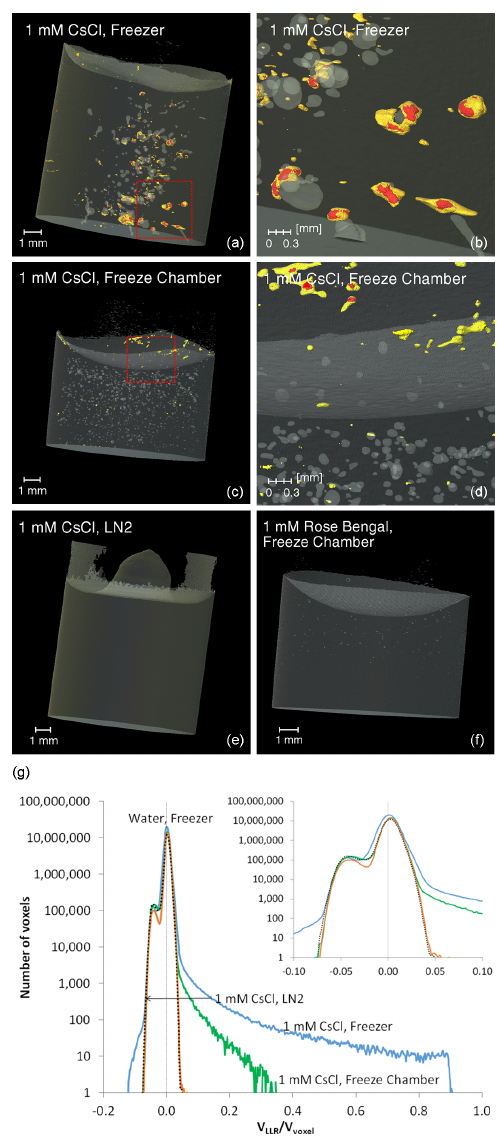
Figure 3. Reconstructed images and histograms of ice samples frozen using three freezing methods and with two different solutes. Samples were imaged using a ∼ 16µm voxel size and segmented to show air bubbles (light gray), the bulk ice matrix (darker gray), voxels where V LLR /V VOXEL is between 2 and 10% (orange), and voxels where V LLR /V VOXEL >10% (red). The sample vial is not shown. (a) 1.0mM CsCl solution frozen in freezer. (b) Magnifica- tion of the area in panel (a) identified by the dashed red square. (c) 1.0mM CsCl solution frozen in freeze chamber (without metal plates). (d) Magnification of the dashed-line area of panel (c) . (e) 1.0mM CsCl solution frozen in liquid nitrogen. No air bubbles or inclusions are visible at this scale. (f) 1.0mM rose bengal solu- tion frozen in freeze chamber. (g) Histogram showing distribution of voxel counts for the CsCl and Milli-Q water ice samples shown above: water ice frozen in freezer, black dotted line; 1.0mM CsCl frozen in LN2, orange line; 1.0mM CsCl frozen in freezer, blue line; 1.0mM CsCl, frozen in freeze chamber, green line. The inset shows an expanded view from V LLR /V VOXEL = − 0 . 1 to